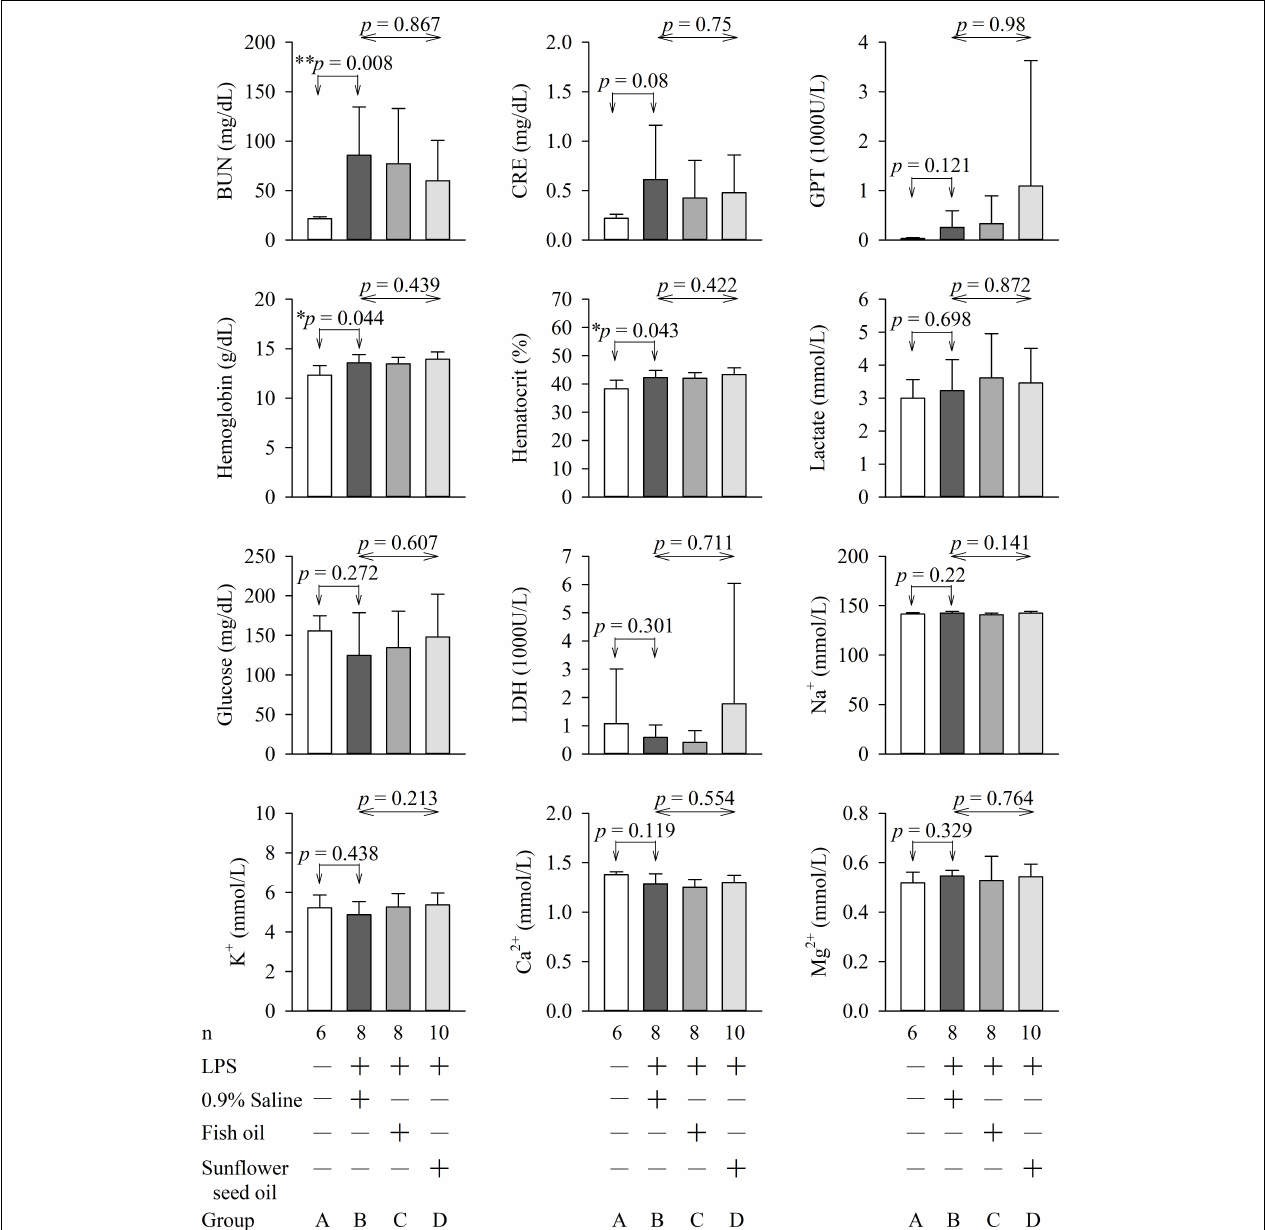
FIGURE 6 | Effects of dietary supplementation of fish oil and sunflower seed oil on the levels of BUN, creatinine, GPT, hemoglobin, hematocrit, lactate, glucose, LDH, Na + , K + , Ca 2 + , and Mg 2 + ). Data are expressed as mean ± SD. BUN, blood urea nitrogen; GPT, glutamate pyruvate transaminase; LDH, lactate dehydrogenase; LPS, lipopolysaccharide; n, number of rats that